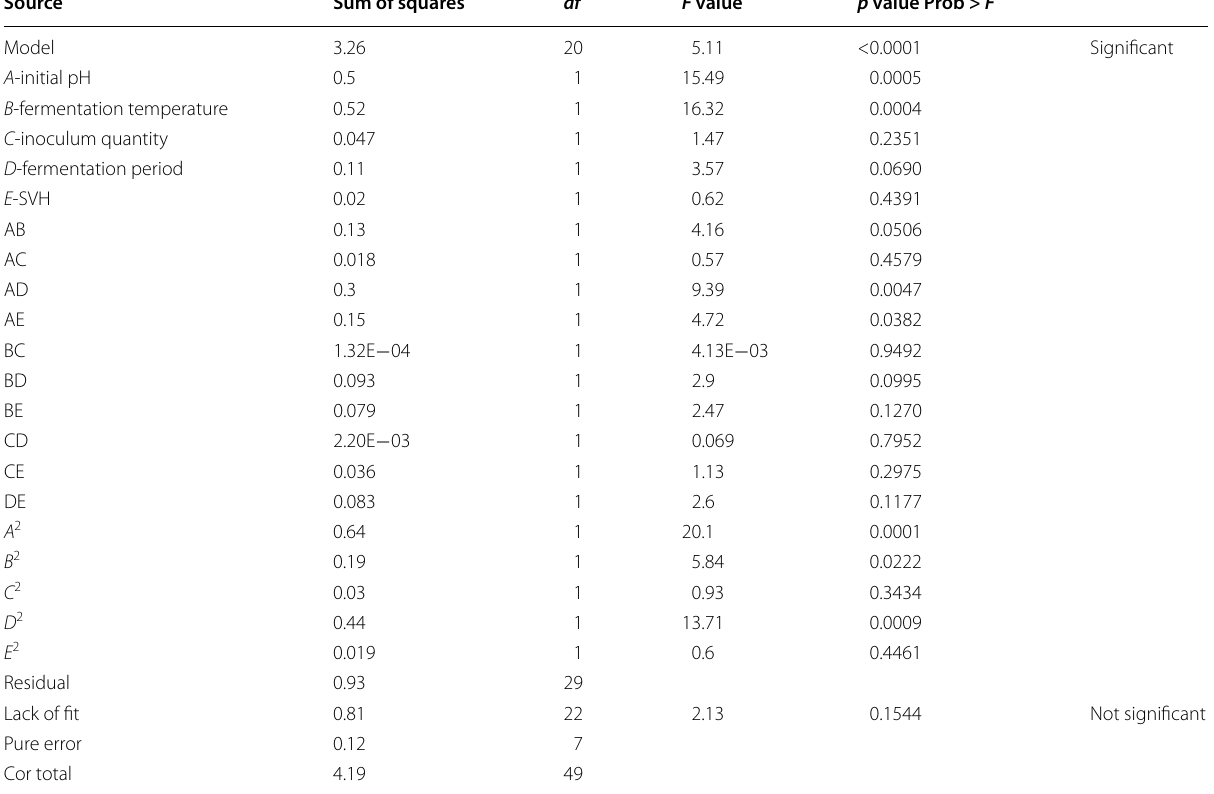
Coefficient of determination ( R 2 ) 0.7788, CV 7.31%. The “Pred R-Squared” of 0.2324 was not as close to the “Adj R-Squared” of 0.6262 as one might normally = = expect. The “Adeq Precision” value of 10.000 indicated an adequate signal